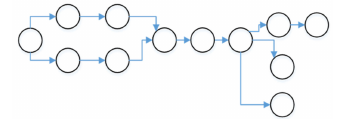
Figure 15. An example of precedence constrains of a single job in a flexible job shop system. An arbitrary DAG represents the precedence between operations of the job